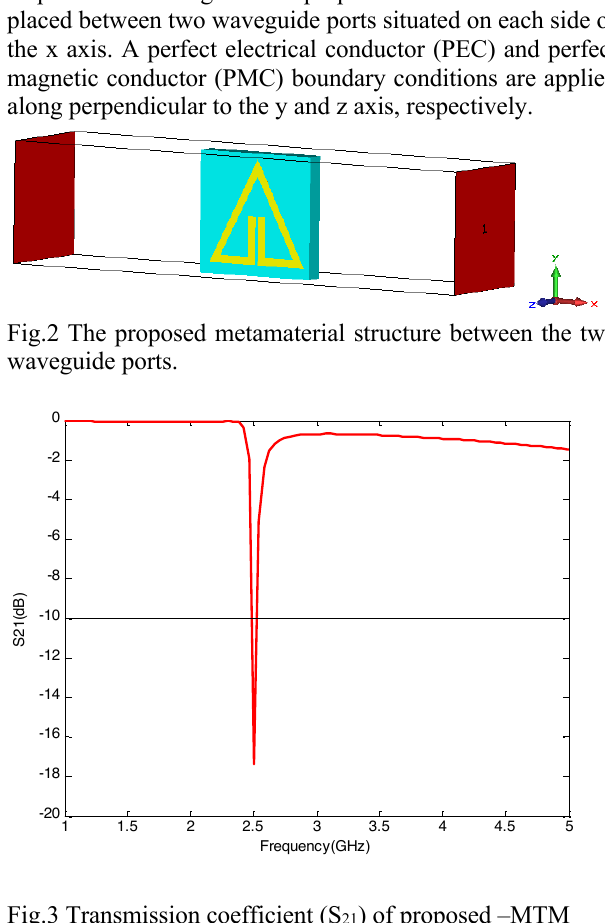
Fig.3 Transmission coefficient (S 21 ) of proposed –MTM